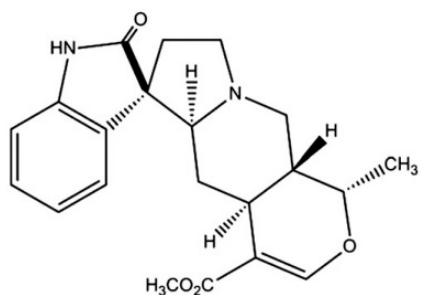
Figure 2. Chemical structure of mitraphylline.